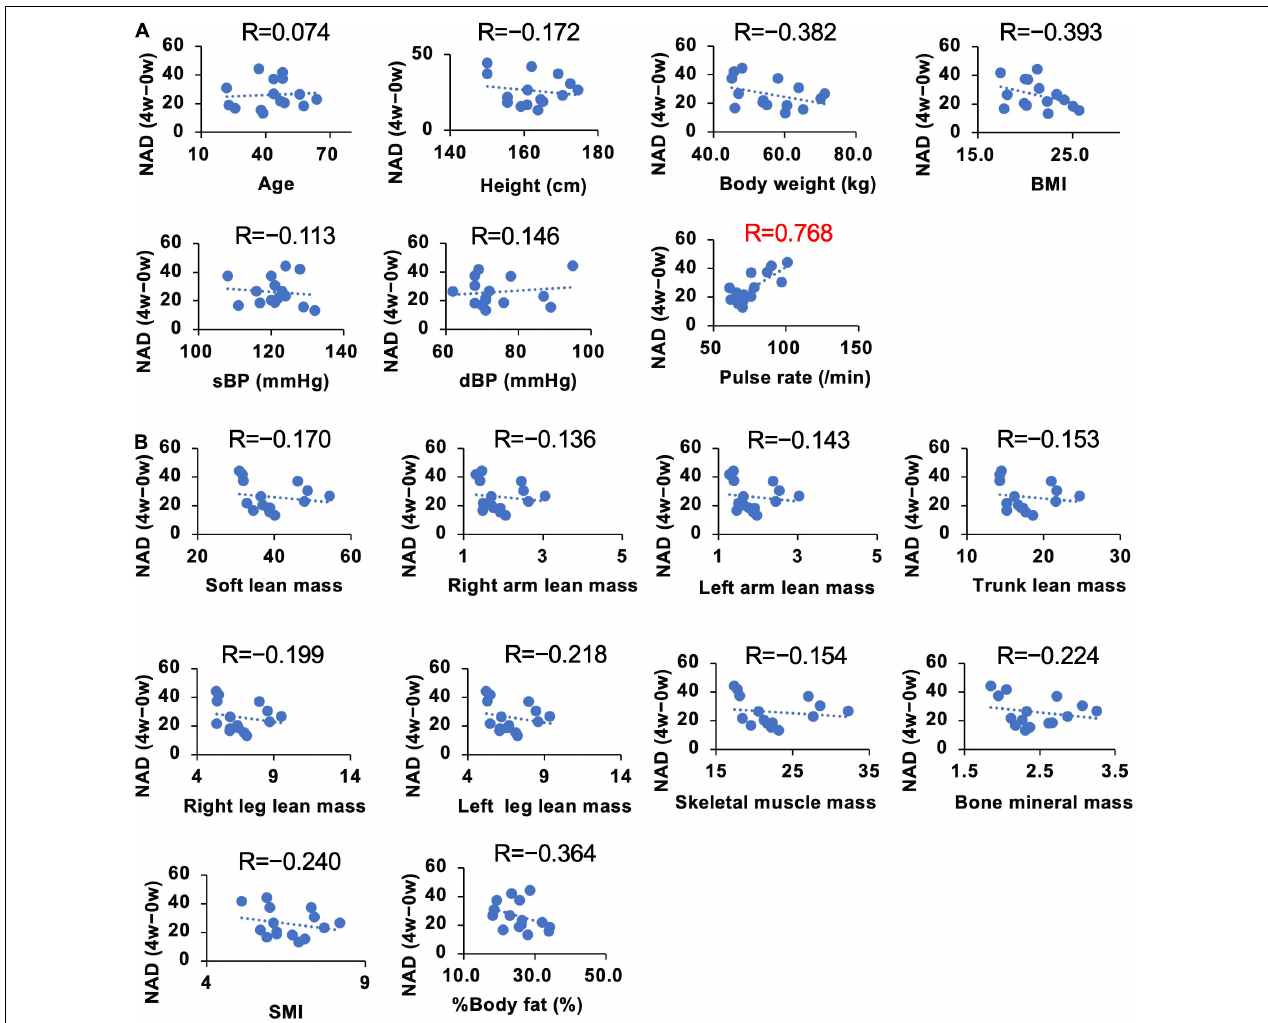
FIGURE 8 | Correlation between individual basal physical parameters and amounts of increased NAD + levels. The Y axis of each panel was fixed as the difference of blood NAD levels in 4 weeks. NAD levels at 0 weeks were subtracted from NAD levels at 4 weeks to calculate the change. Basal physical parameters (A) and body composition (B) at 0 weeks were compared with the difference of NAD at 4 weeks. Correlation coefficients were calculated by using Pearson’s correlation coefficient formula and indicated as R on the top of each